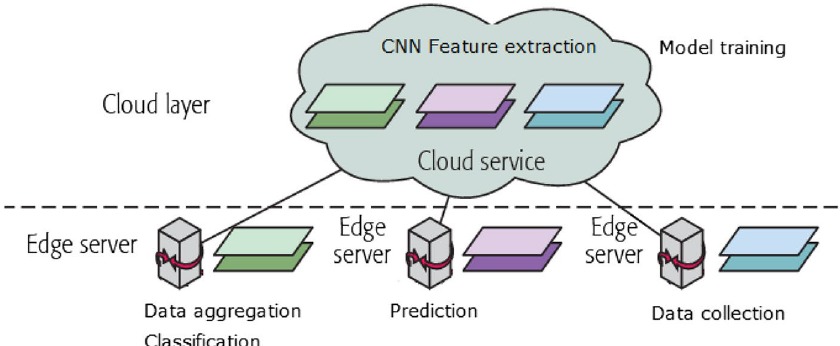
Fig. 13 Architecture diagram of the online teaching system